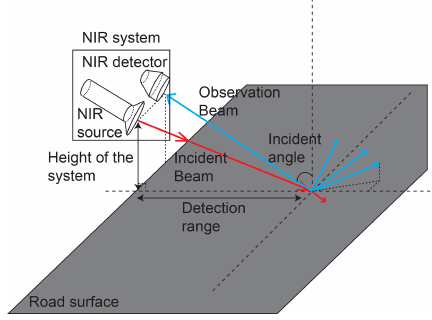
Figure 2. General configurations of NIR